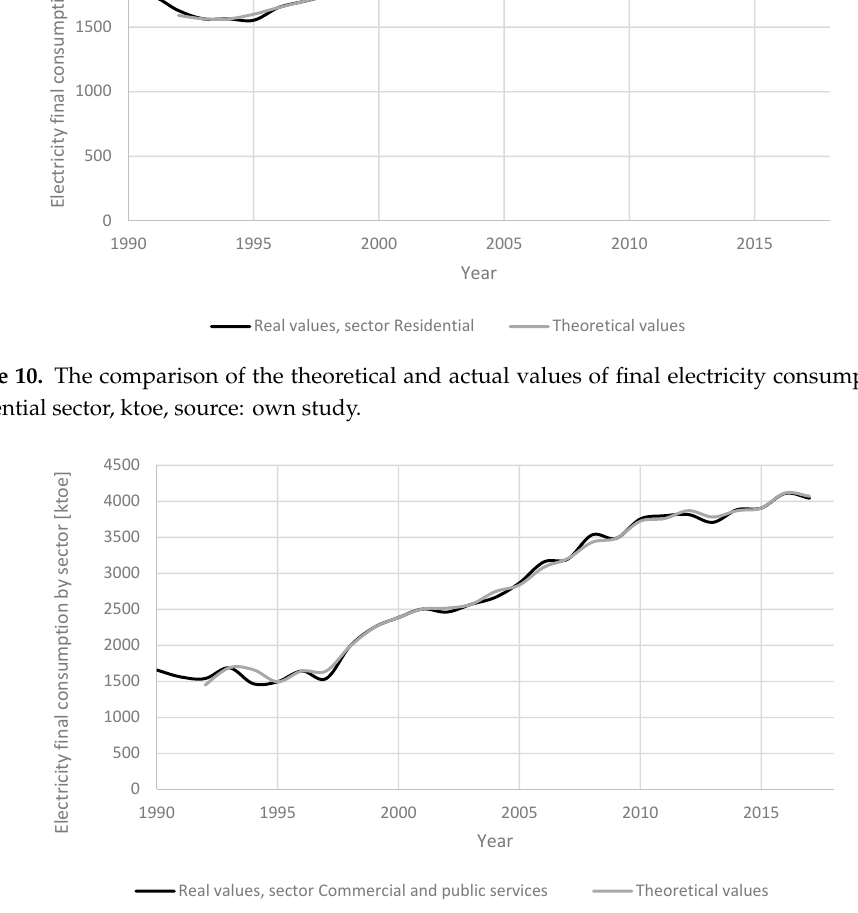
Figure 11. The comparison of the theoretical and actual values of final electricity consumption for commercial and public services sector, ktoe, source: own study.